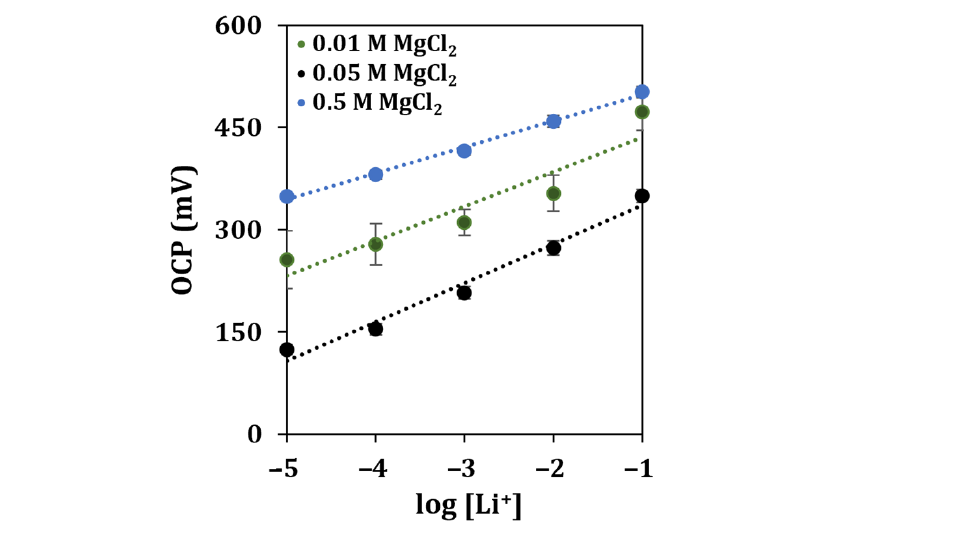
Figure 8. Lithium detection in contaminated soils diluted at a 1:100 ratio in different concentrations of the supporting electrolyte. Each measurement was repeated at least 5 times using the same sensor.